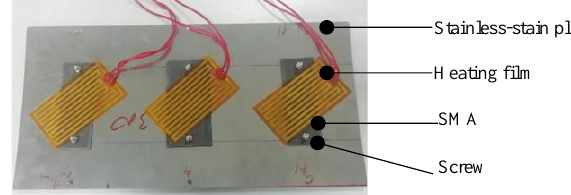
Figure 13. Active morphing skin prototype.